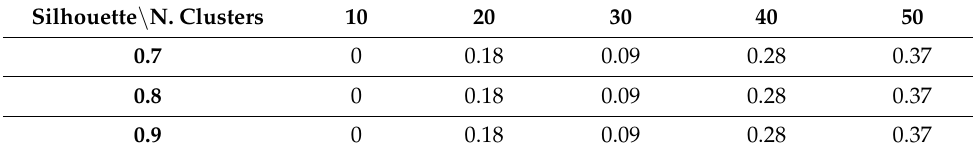
Table 55. Clustering performance in terms of silhouettes using original data. Silhouette \ N. Clusters